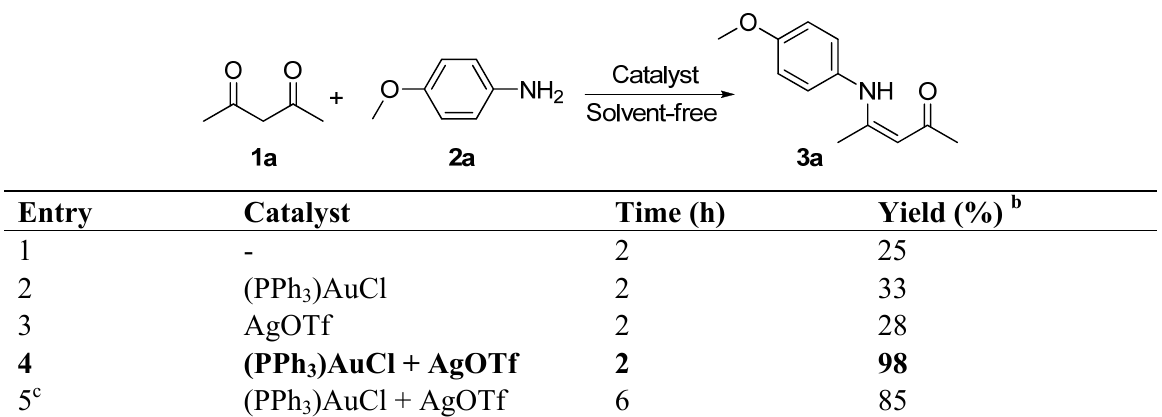
Table 1. Screening of the reaction conditions for the enamination a